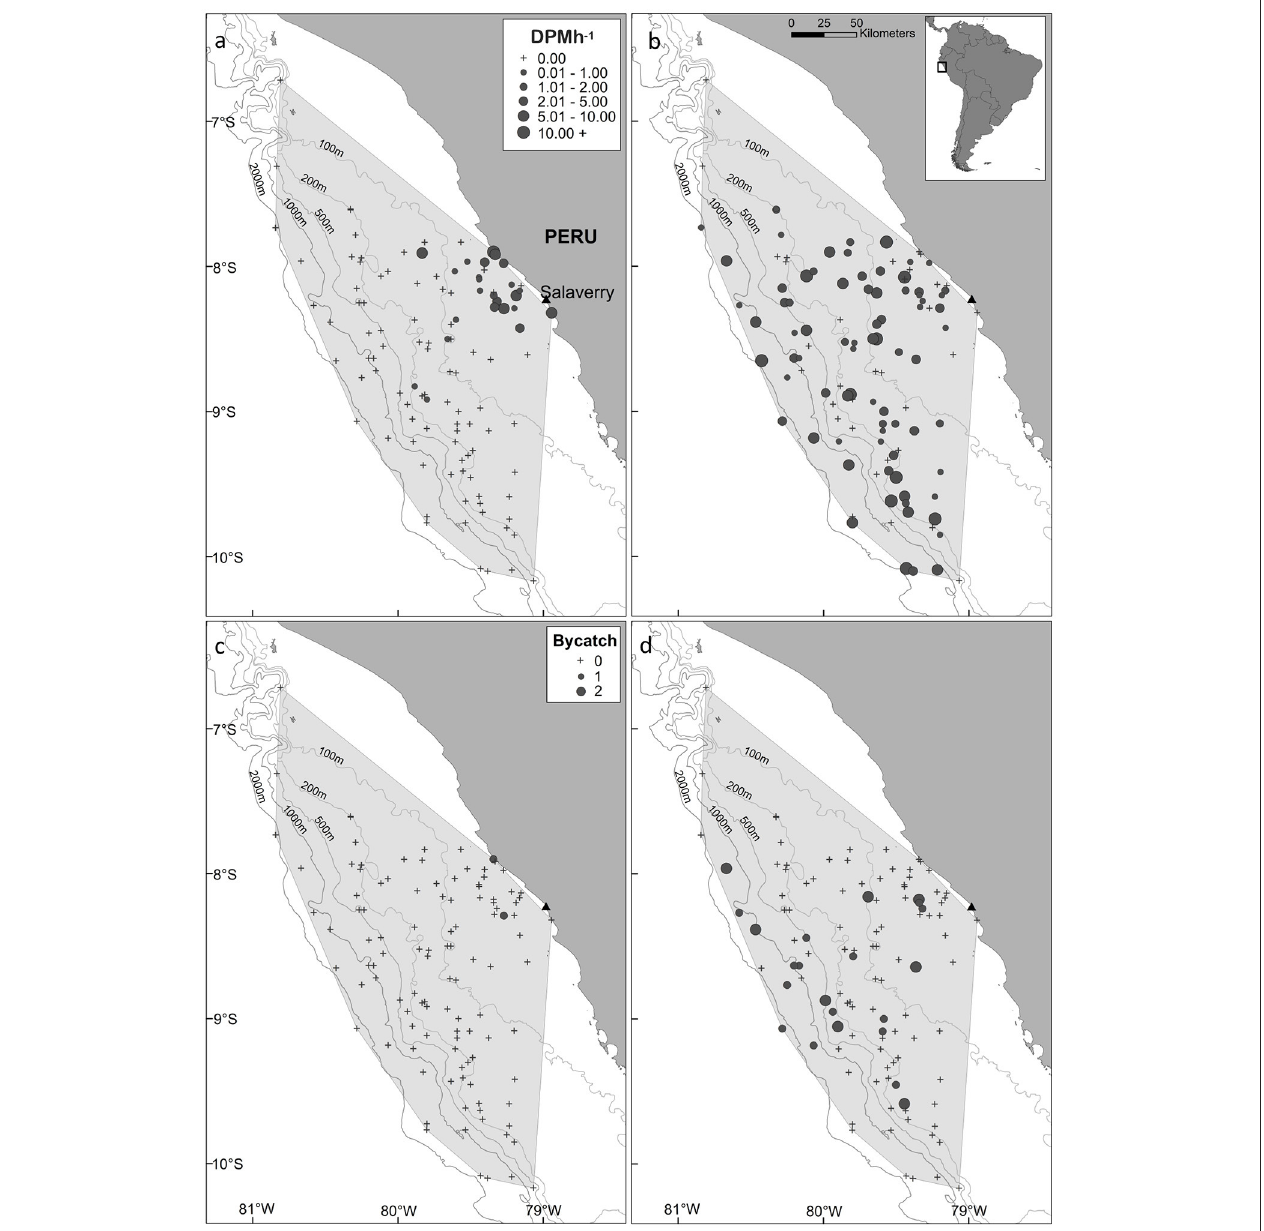
FIGURE 2 | Map of the study area, (a,b) acoustic activity recorded by C-PODs attached to gillnets and (c,d) bycatch, of Burmeister’s porpoise (left panels) and dolphins (unspecified delphinids; right panels) in fishing vessels operating from the port of Salaverry, northern Peru. For plots of acoustic activity and bycatch, the locations of sets where small cetaceans were present and absent are shown by circles and crosses, respectively, with the size of circles representing time spent [detection positive minutes (DPM) per hour] and the number of individuals captured, respectively. The shaded area represents the minimum convex polygon of fishing sets, and the position of the 100, 200, 500, 1,000, and 2,000m isobaths are shown with gray lines.